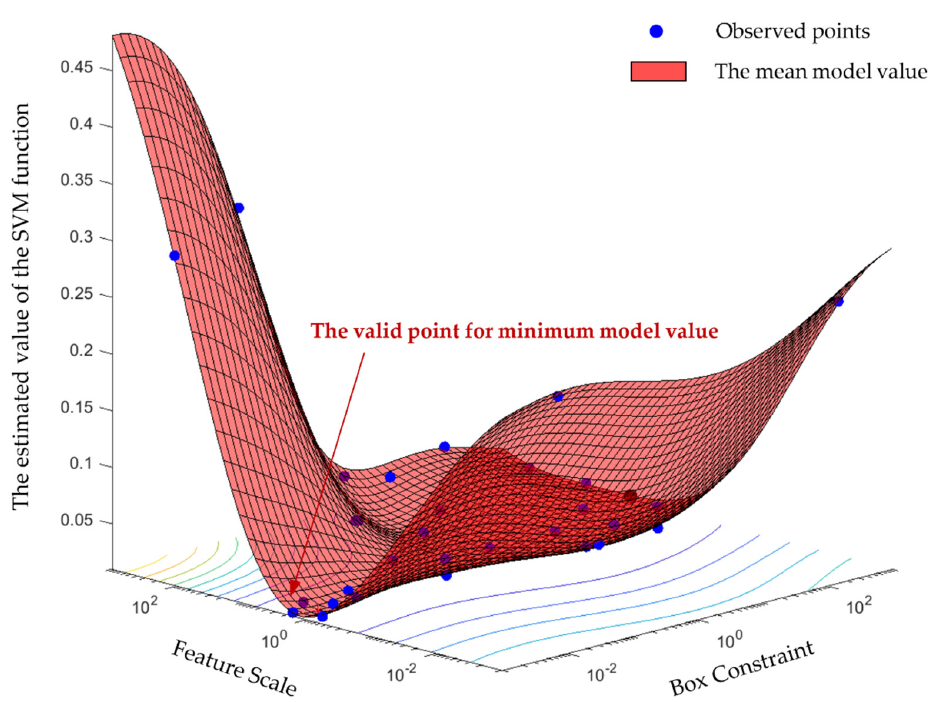
Figure 12. Optimization of hype-parameter Feature Scale and Box Constraint by finding the mini- mum SVM function value. SVM function value.